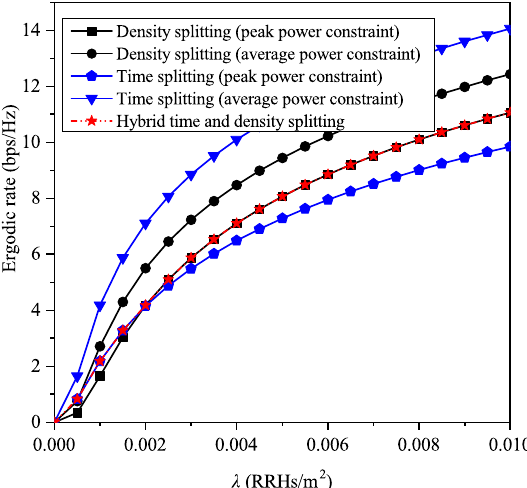
Figure 7. Maximized ergordic rate versus the density λ for β = 3.